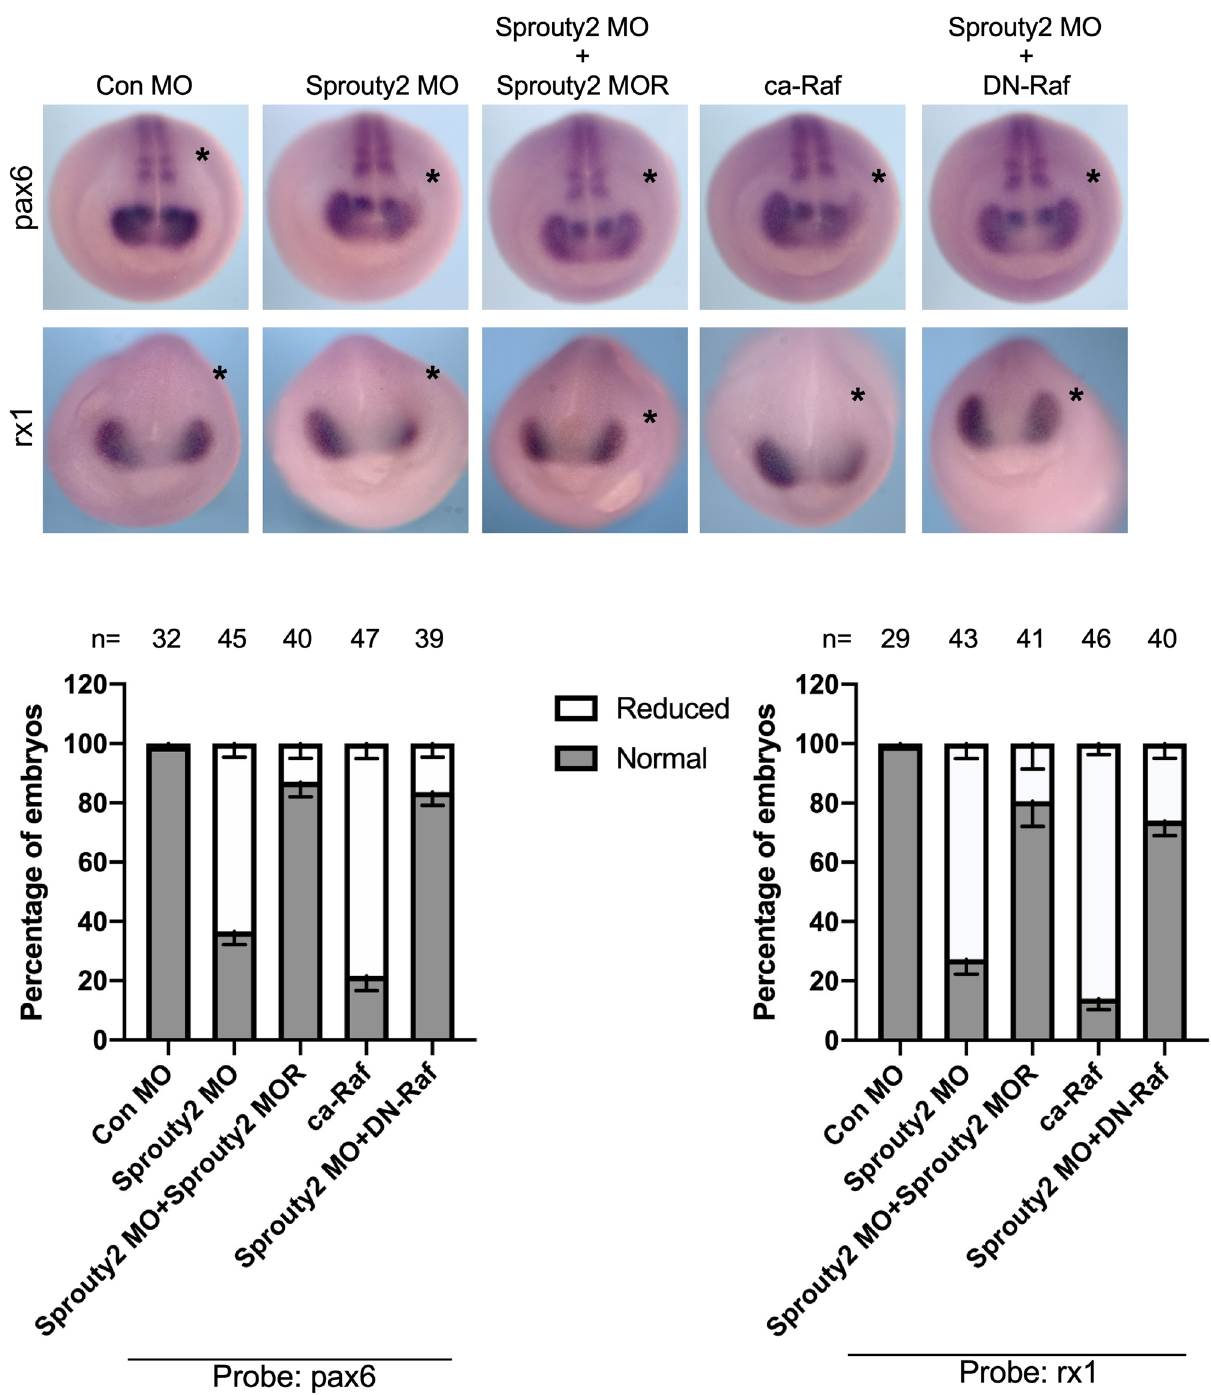
Figure 5. Activation of MAPK signal affects eye specific marker gene expression. D1.1.1 blastomere was injected with RNA or morpholino or a combination of both as indicated. Embryos were then collected at stage 18 and subjected to whole-mount in situ hybridization for eye marker genes pax6 and rx1 . Asterisk indicates the injected side. Histograms represent the percentage of embryos with normal or reduced expression of rx1 or pax6 from three biological repeats. Quantification with unpaired t test, P < 0.001, Error bars indicate ±